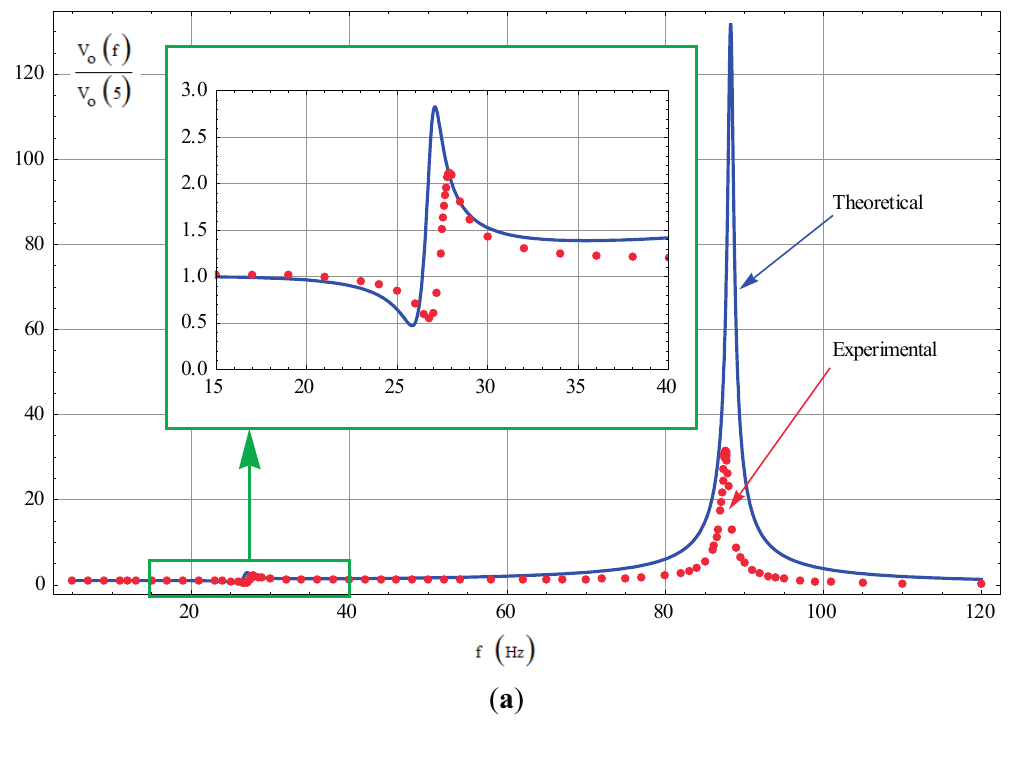
Figure 12. ( a ) Theoretical and experimental input-output amplitude-frequency responses of SG-1; ( b ) Theoretical and experimental input-output amplitude-frequency responses of